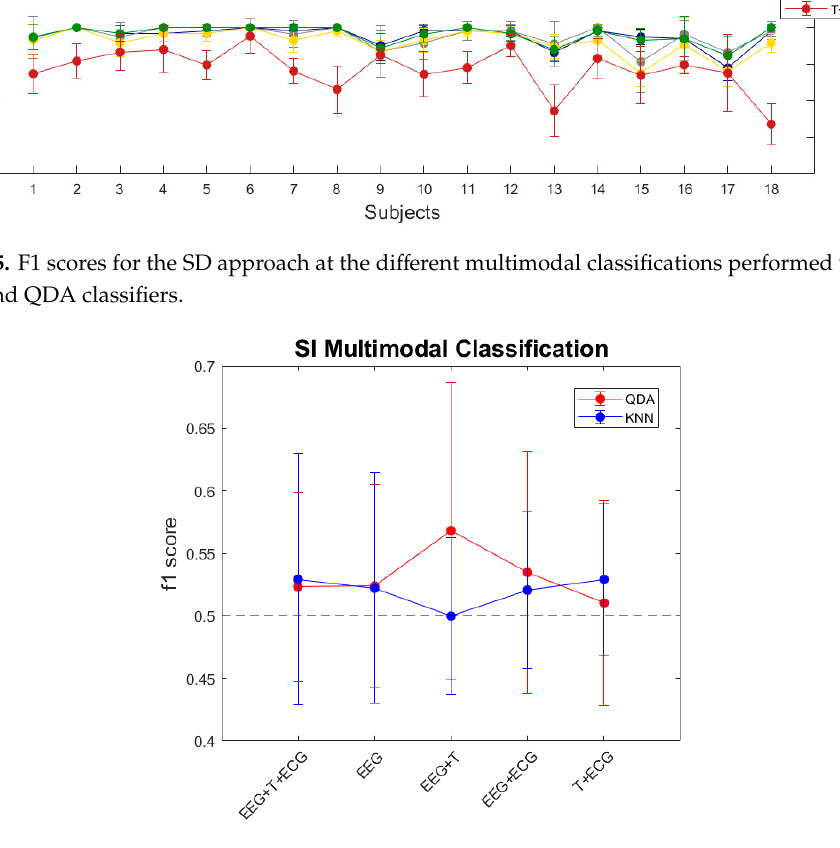
Figure 6. F1 scores for the SI approach at the different multi-modal classifications performed with the KNN and QDA classifiers. The black dotted line corresponds to value of chance.